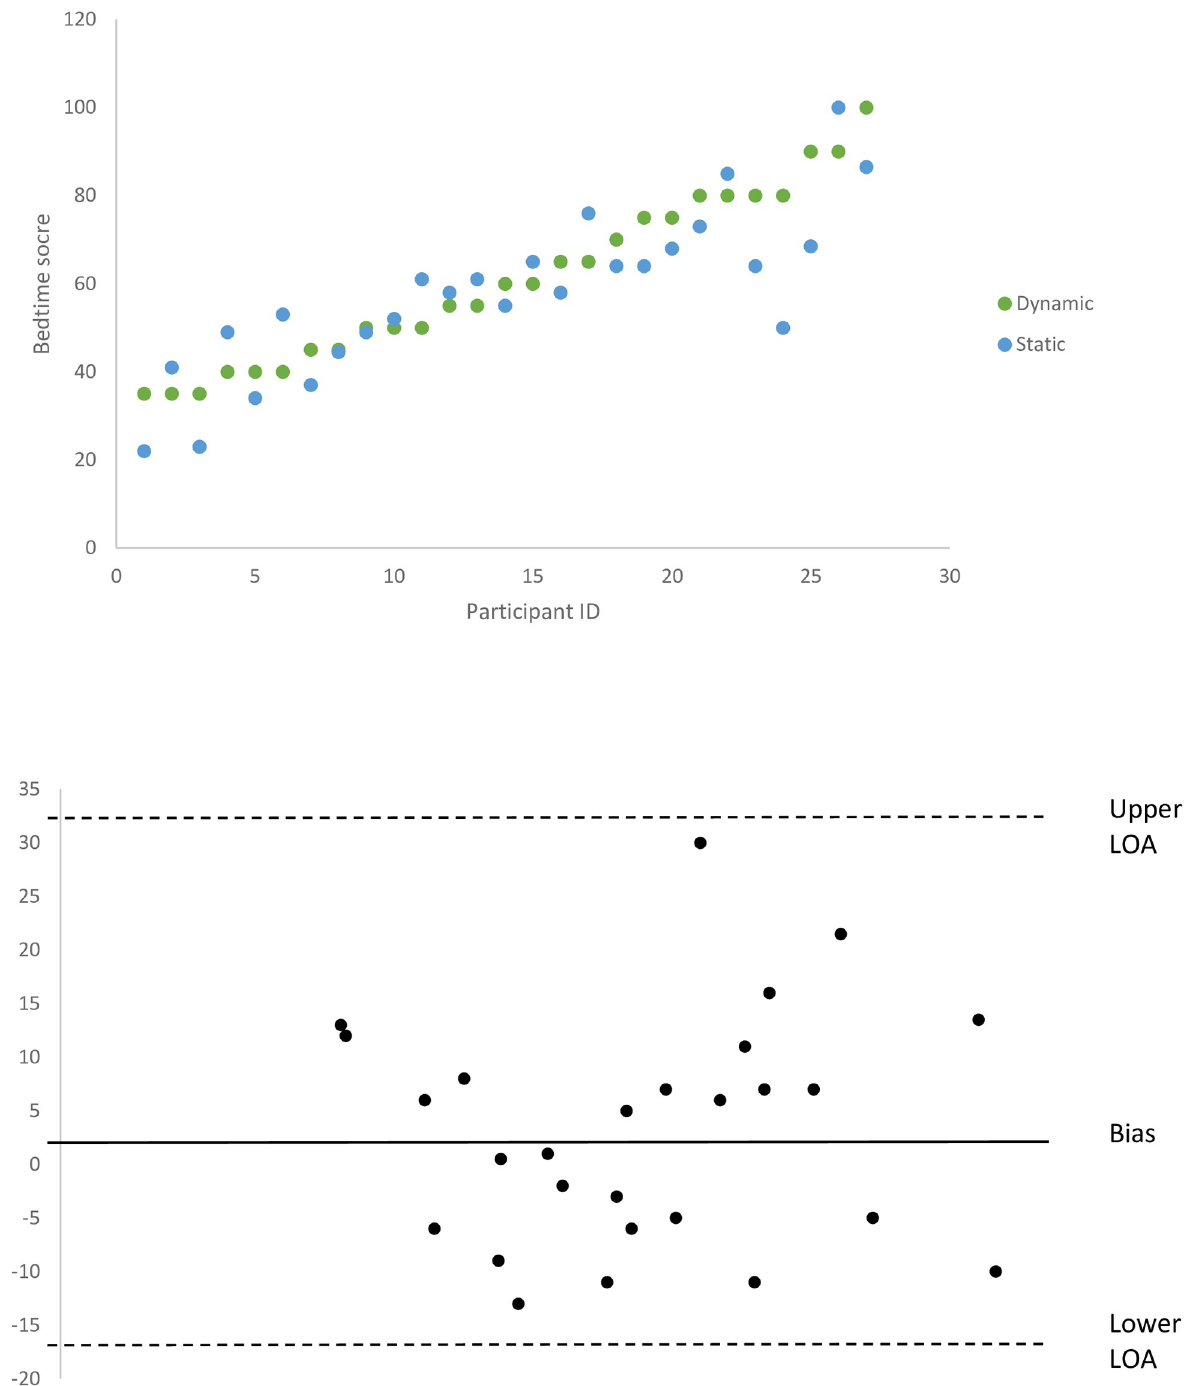
Fig 2. Static vs. dynamic assessment of bedtime routines; differences in individual scores per type of measurement & Bland-Altman difference plot.